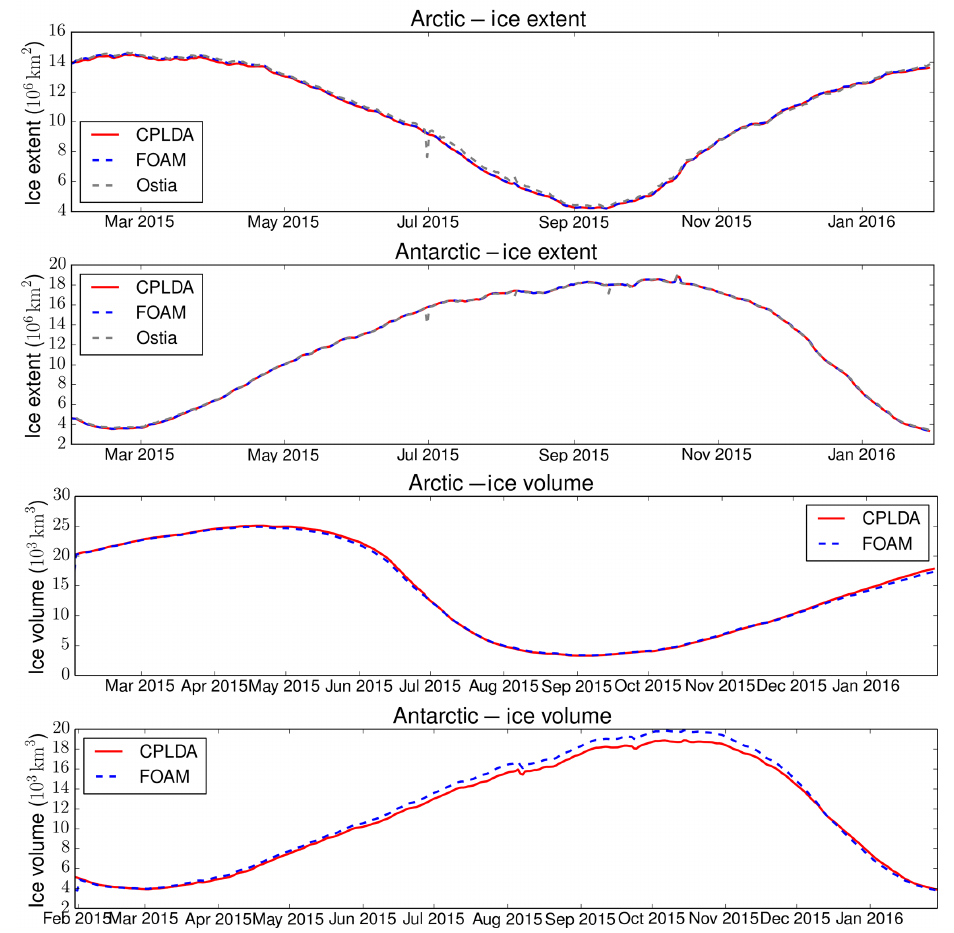
Figure 3. Time series of sea ice extent and sea ice volume for CPLDA (2015 experiment) and